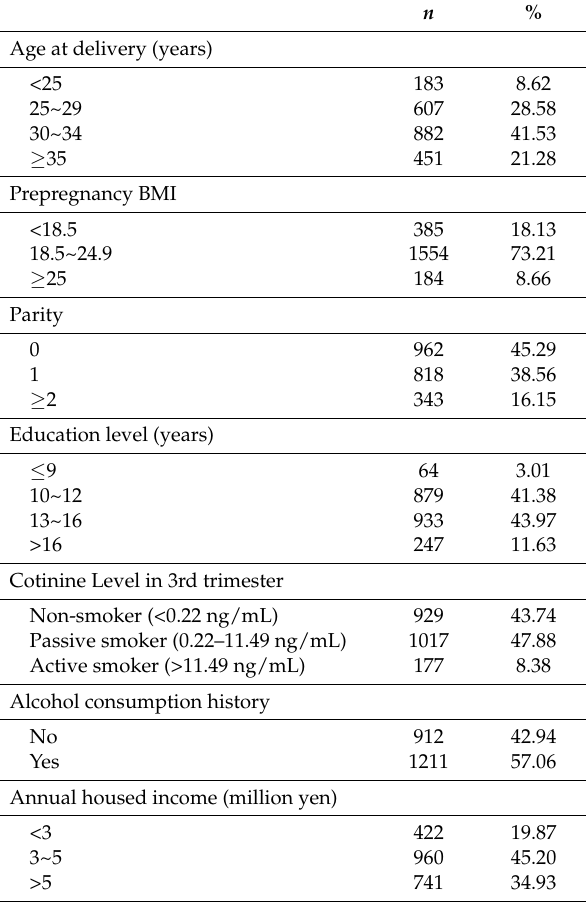
Table 1. Maternal basic characteristics ( n =